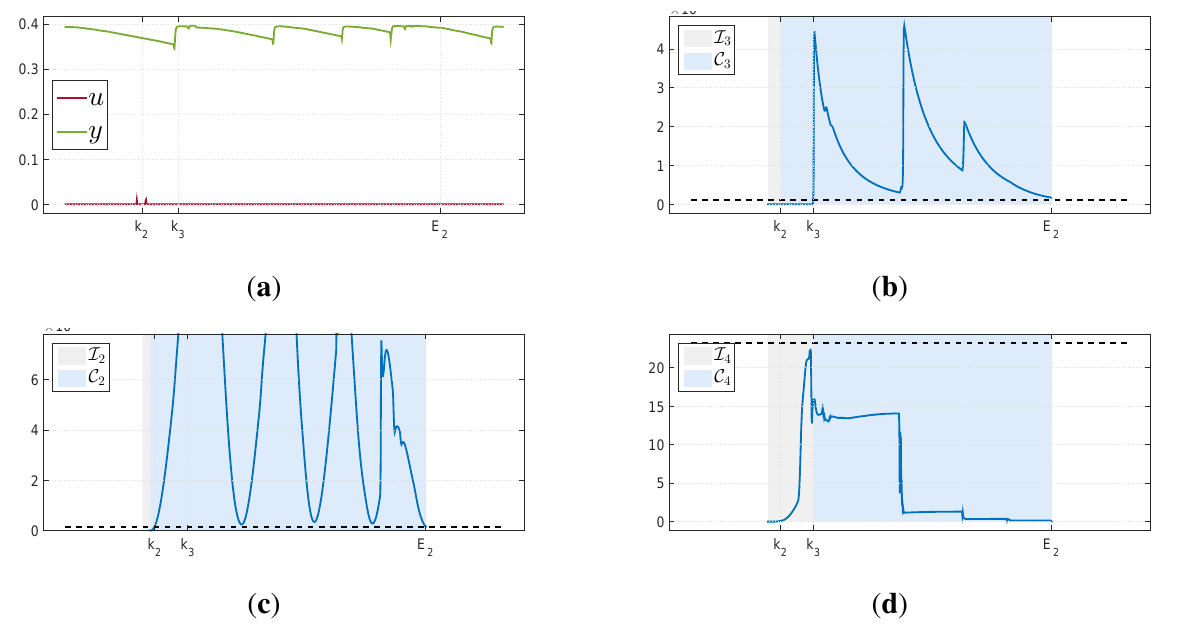
Data under a significant disturbance that was rejected by the algorithm. ( a ) Temperature, open loop; ( b ) Test for numerical conditioning of ¯ R ( k ) ; ( c ) Test for variance of y ; ( d ) Granger causality